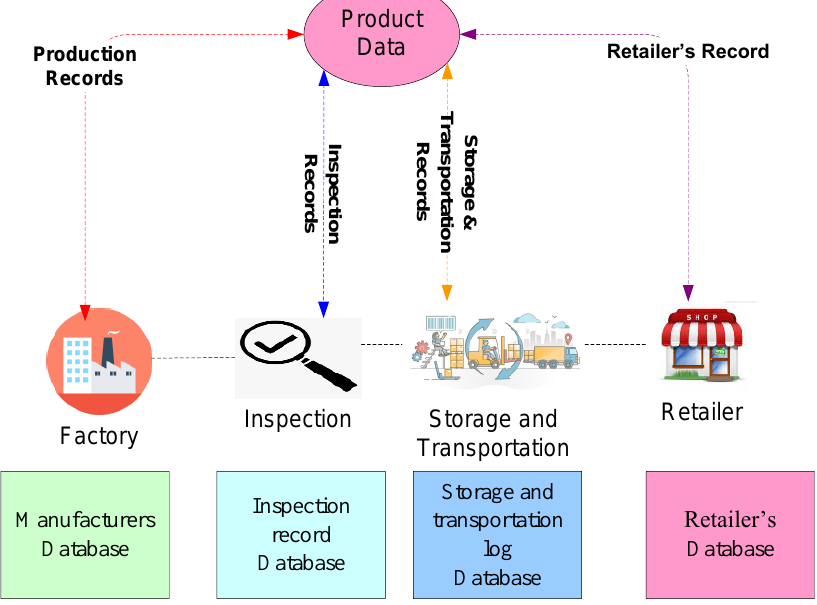
Figure 5. Application of IoT in sustainable